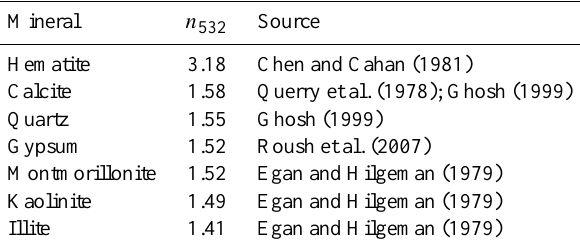
Table 5. Refractive indices of several minerals at 532nm. Note that illite has a much lower refractive index than the other common dust species, so regional variability in the relative fraction of illite causes regional variability in the real refractive index of